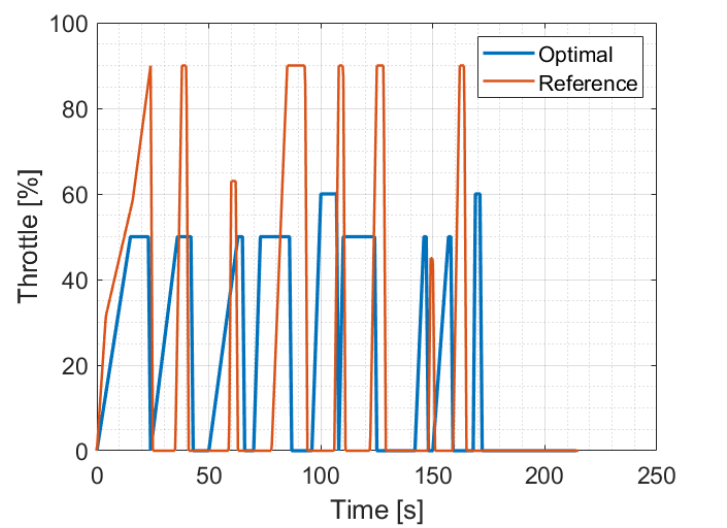
Figure 9. Comparison between the optimal input throttle command and the reference throttle command employed for model